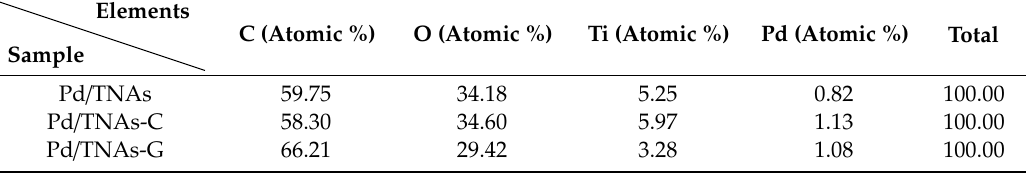
Table 1. The percentage of each element by XPS analysis of Pd / TNAs, Pd / TNAs-C and Pd /